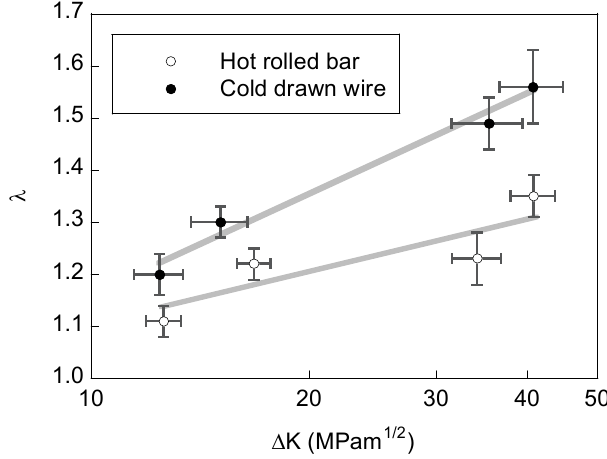
Figure 5. Profile length ratio, λ , vs. stress intensity factor range, Δ K , for the hot rolled bar and the cold drawn wire.